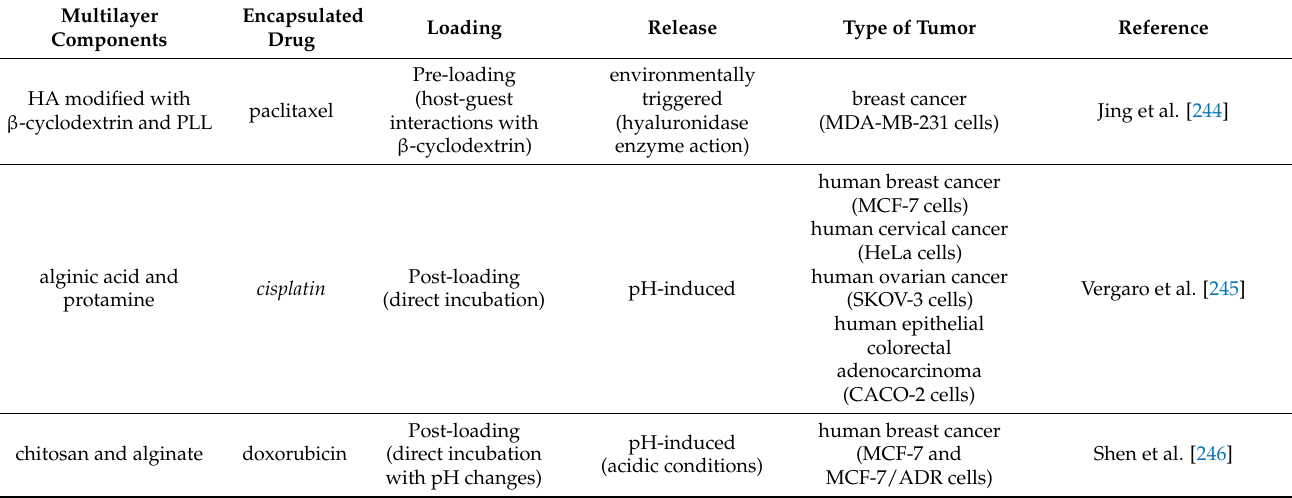
Table 2. Summary of multilayered capsules used for antitumoral drug